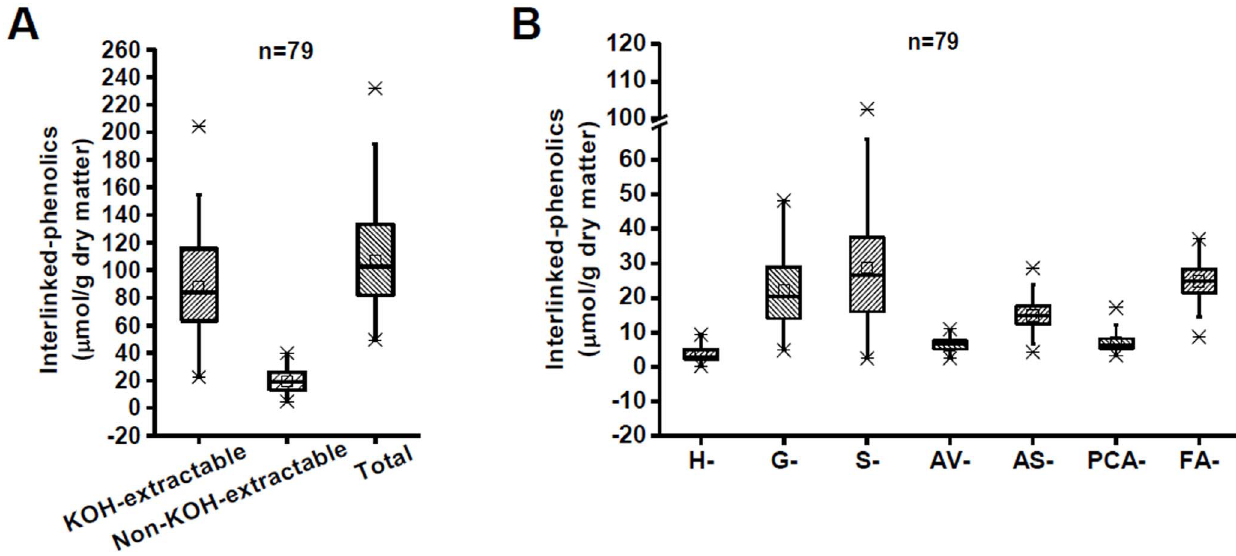
Figure 2. Variation of interlinked-phenolics in Miscanthus (n=79). (A) Interlinked-phenolics in the KOH-extractable and non-KOH-extractable residues; (B) Total interlinked-phenolic compositions. H-: p -Hydroxybenzaldehyde, G-: Vanillin, S-: Syringaldehyde, AV-: Acetovanillone, AS-: Acetosyringone, PCA-: p- Coumaric acid, FA-: Ferulic acid, SA-: Sinapic acid.